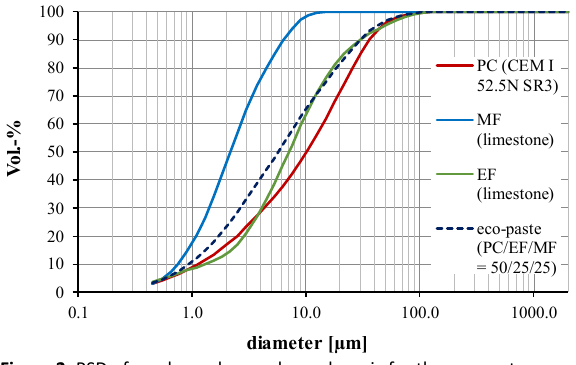
Figure 2. PSD of used powders and powder mix for the eco